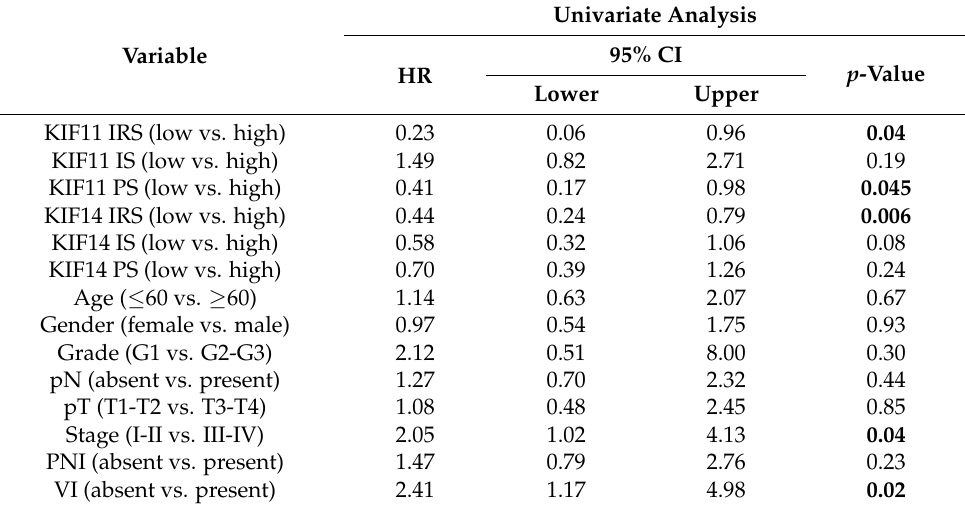
Univariate Analysis